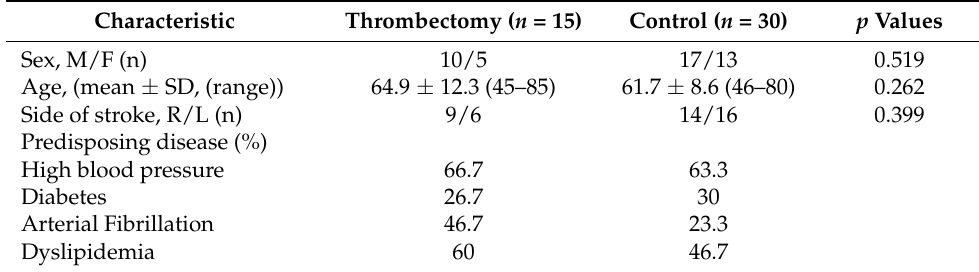
Table 1. Patient demographic and clinical